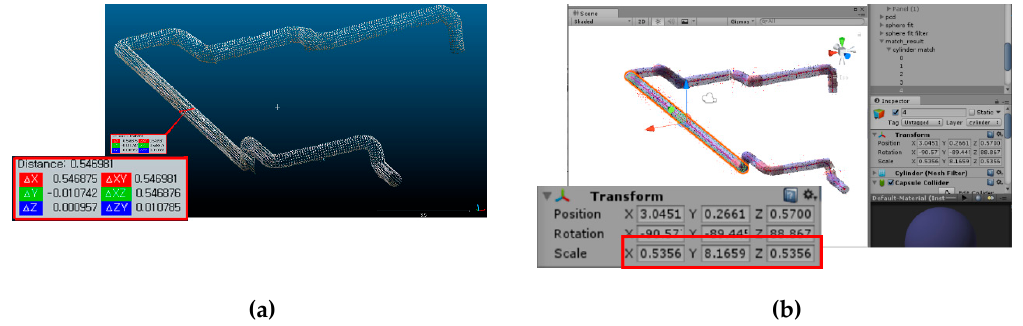
Figure 6. Estimating the accuracy of matching results: ( a ) CloudCompare point distance; ( b ) proposed method diameter.